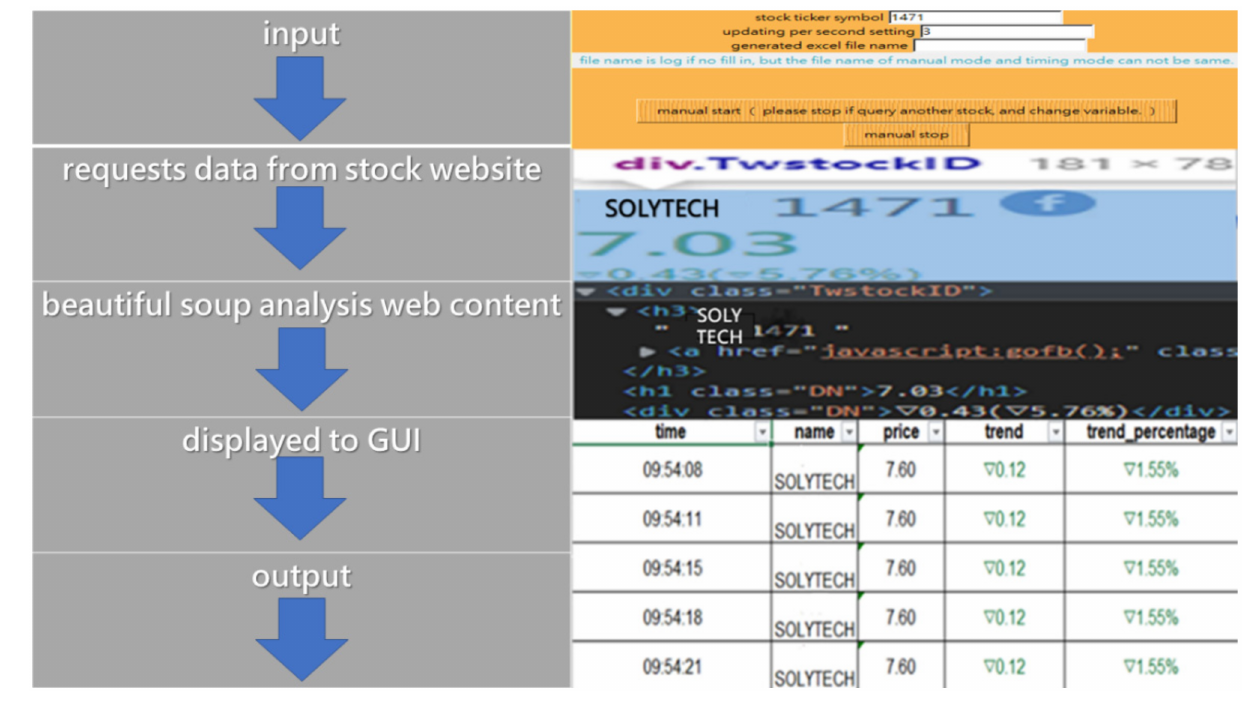
Figure 9. Input and output of the flow chart.